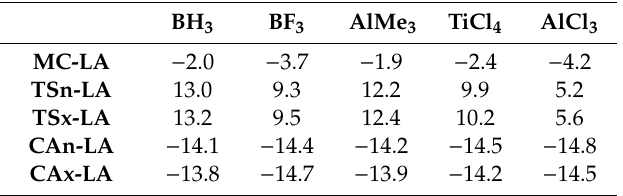
Table 3. B3LYP / 6-311G(d,p) gas phase relative energies, with respect to separate reagent in kcal · mol − 1 , of the stationary points involved in the P-DA reactions between Cp 1 and the series of LA